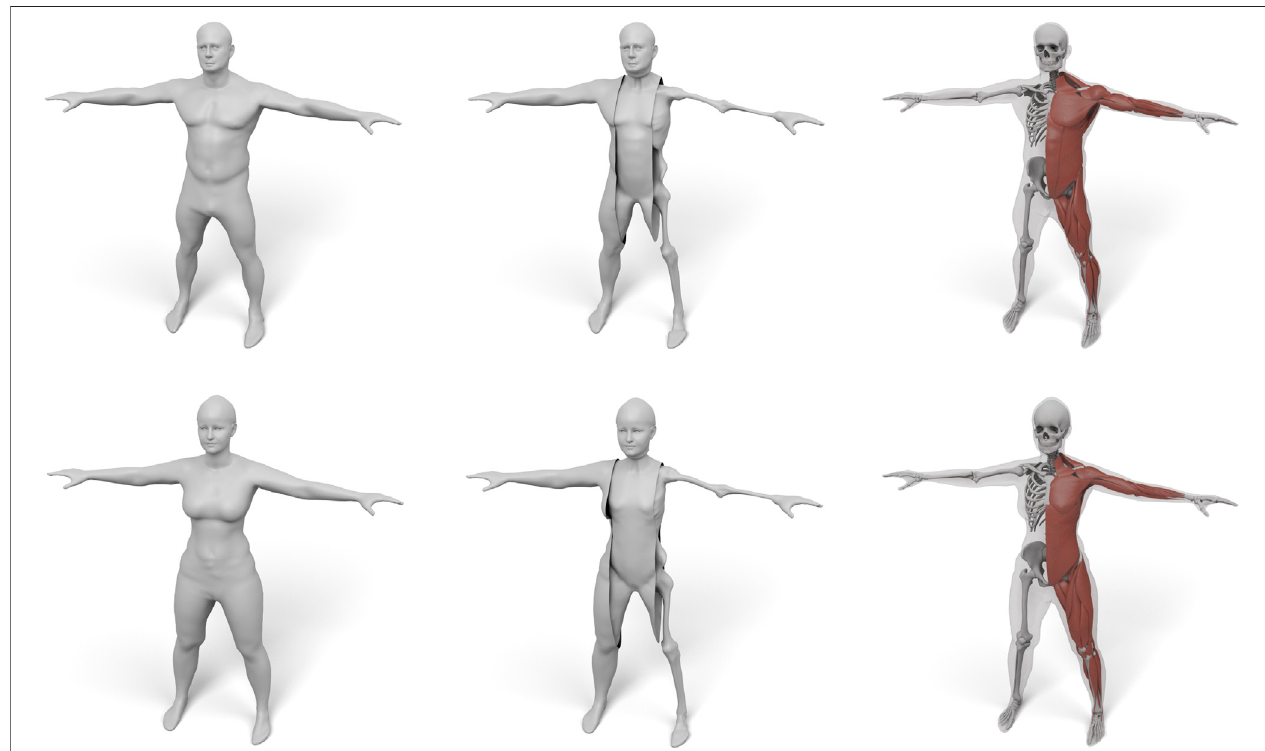
FIGURE 1 | Starting from the surface ofa human (left) , we fi t a three-layered model consisting of a skin, muscle, and skeleton layer (middle) , which enables physical simulations in a simple and intuitive way. terior structures, such as individual models of muscles and bones, can also be transferred using our layered model (right) .